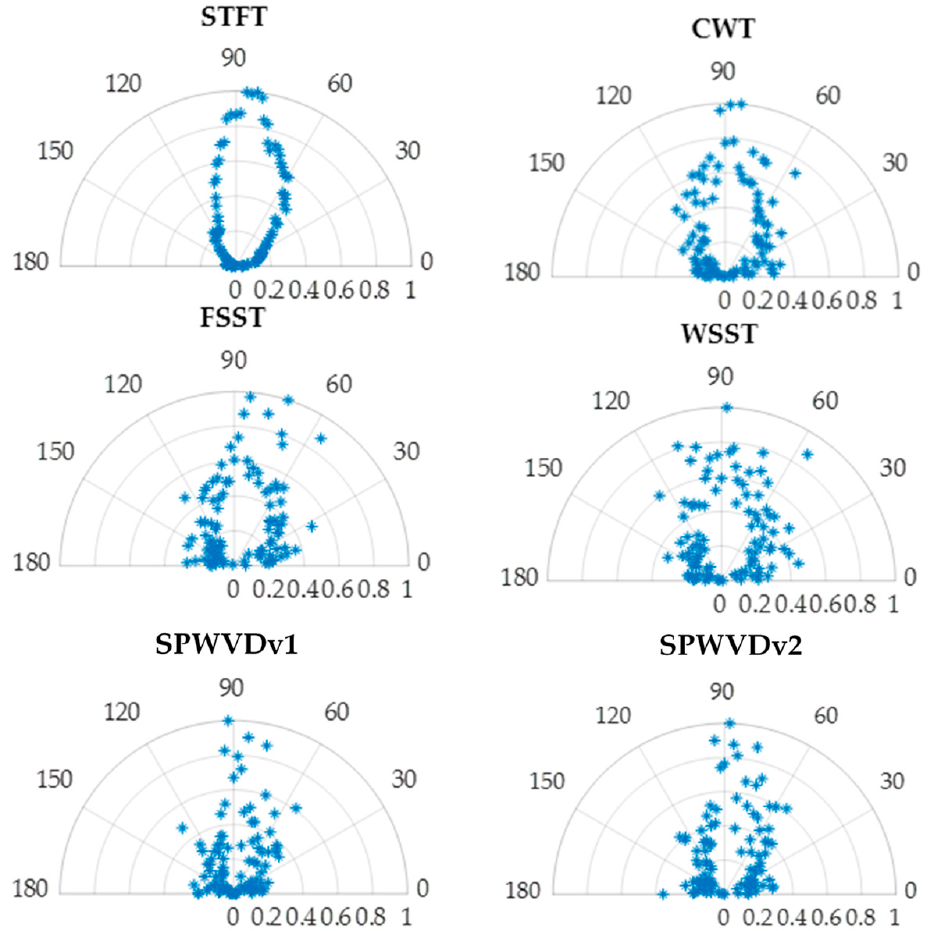
Figure 7. First principal component for each of the transformations .